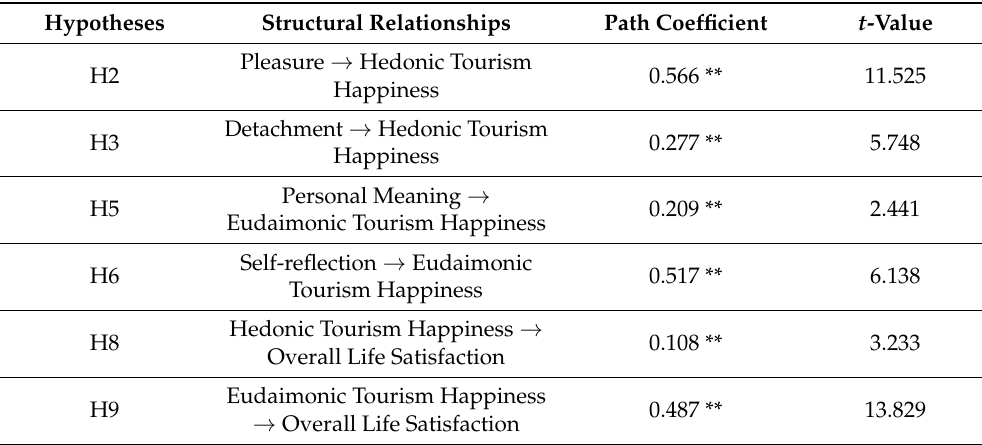
Table 7. Hypothesis